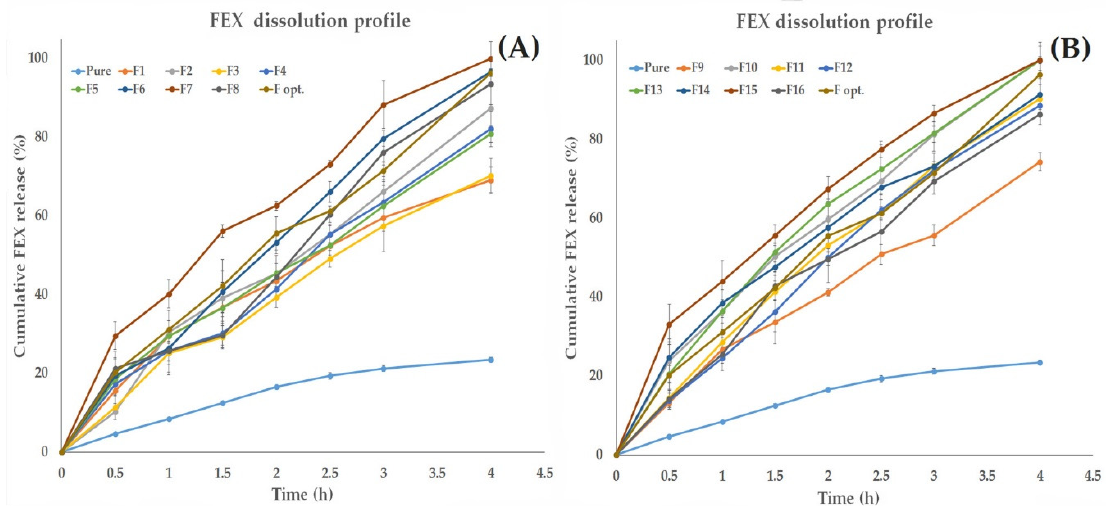
Figure2. In vitrodissolutionprofileofallpreparedFEXEIFVcomparedtoFEXpowder( A )formulations Figure 2. In vitro dissolution profile of all prepared FEX EIFV compared to FEX powder ( A ) 1–8 ( B ) formulations 9–16. formulations 1–8 ( B ) formulations 9–16.